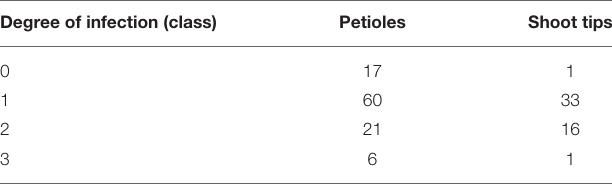
TABLE 1 | Overview of the classification of infected petioles and shoot tips. Degree of infection (class) Petioles